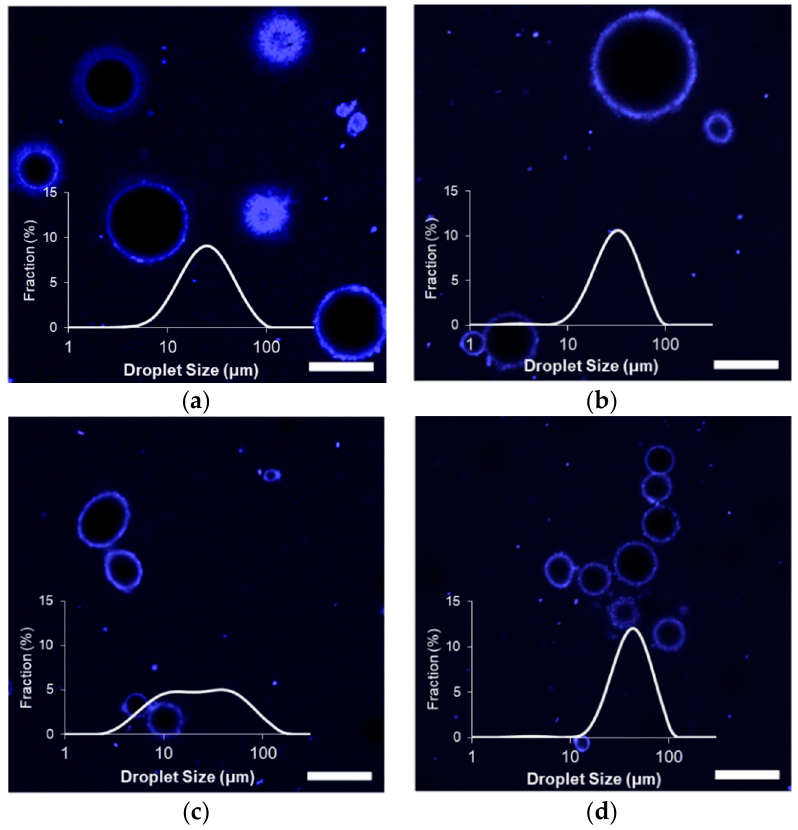
Figure 1. Effect of Blg microgel type on the initial droplet size distribution and morphology of limonene/corn oil-in-water emulsions: ( a ) MG 57 , ( b ) MG 58 , ( c ) MG 59 , ( d ) MG X ; scale bars = 20 μ m.